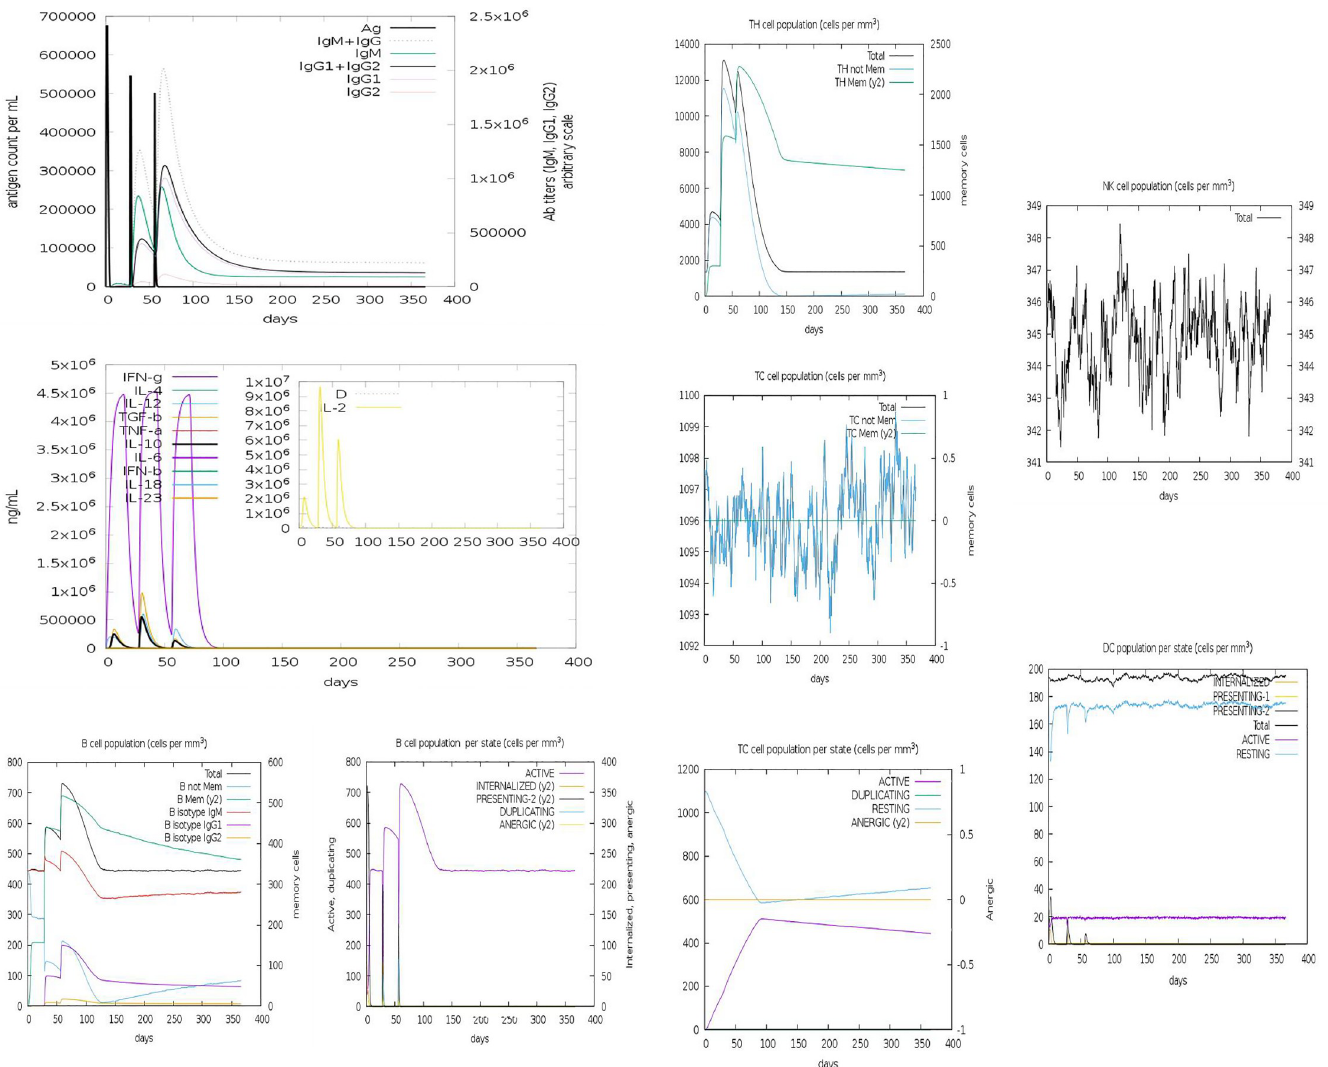
Fig 8. The induced immune cells by the peptide vaccines. ( a ) The concomitant decrease in antigen level with rise in immunoglobin activities. ( b ) Induced array of cytokines during prime boost. ( c) B lymphocytes: total count, memory cells, and sub-divided in isotypes IgM, IgG1 and IgG2. ( d) CD4 T-helper lymphocytes count. ( e) CD4 T-helper lymphocytes count. ( f) CD8 T-cytotoxic lymphocytes count. ( g) CD8 T-cytotoxic lymphocytes count per entity-state. ( h) Natural Killer cells (total count). ( i) Dendritic cells.